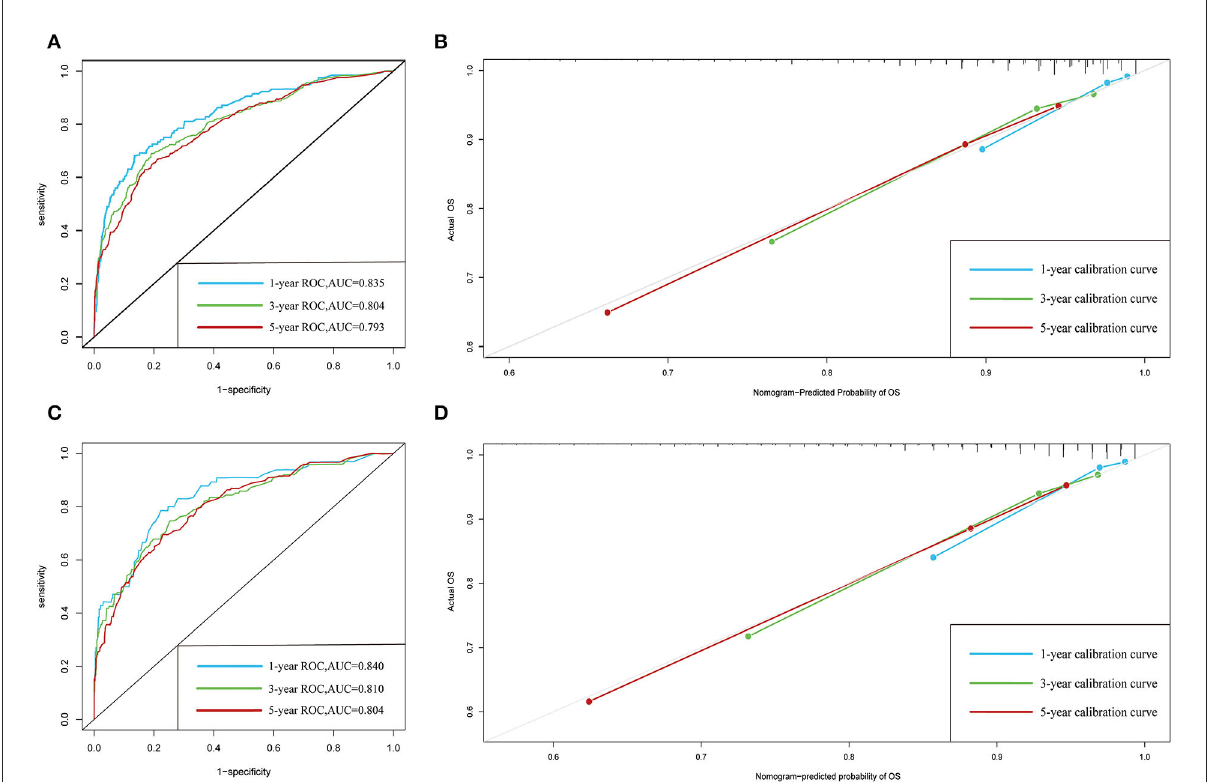
FIGURE3 ROC and calibration curves. (A,B) ROC and calibration curves of 1-, 3-, and 5-year overall survival in the training cohort. (C,D) ROC and calibration curves of 1-, 3-, and 5-year overall survival in the validation